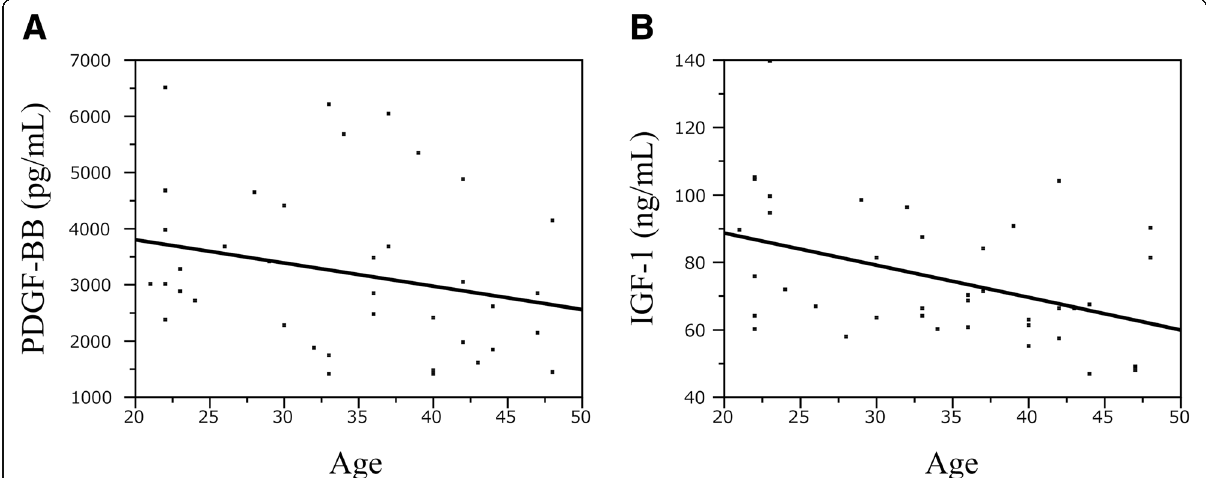
Fig. 1 Correlation between the age of volunteers and concentrations of PDGF-BB and IGF-1 in PRP samples. PDGF-BB and IGF-1 levels significantly correlated with age (Spearman a : PDGF-BB r=-0.32, p <0.05, b : r=0.39, p